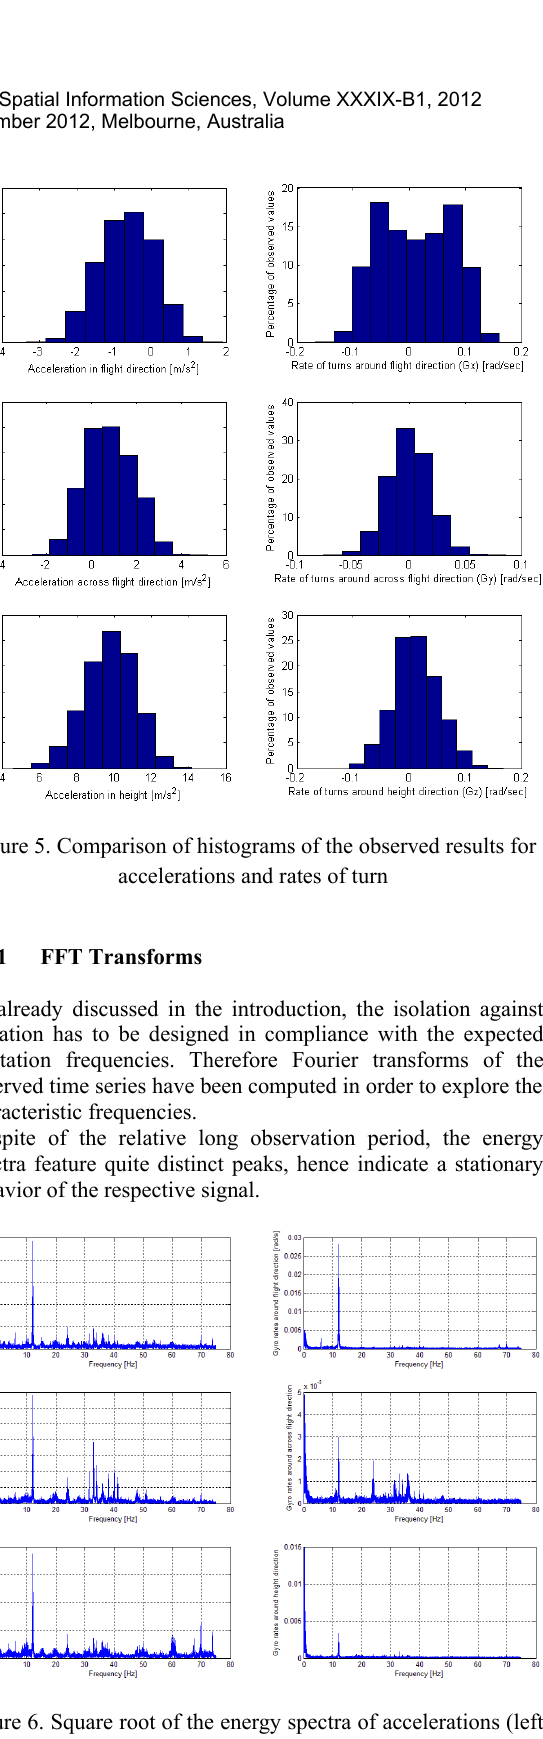
Figure 6. Square root of the energy spectra of accelerations (left column) and rates of turn (right column) related to X, Y,